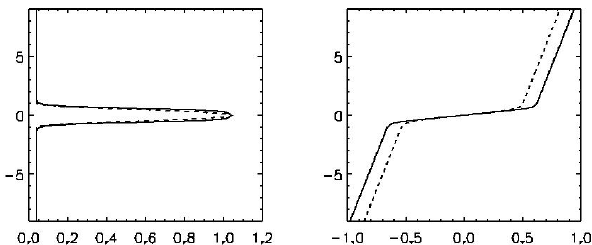
Fig. 5. N 2 (z) (left) and potential temperature profiles (right) for the composite (solid) and cosine (dashed) ducts employed for bore simulations in a domain 9 times deeper than shown in Figs. 3 and